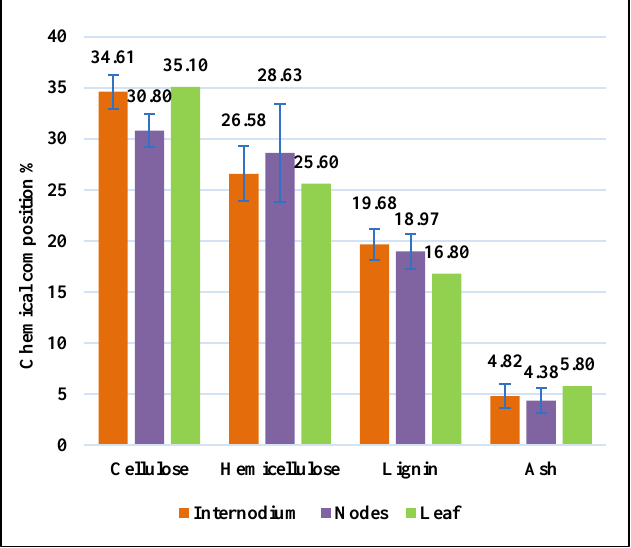
Figure 3: Biomass yield of giant reed plantations in the Mediterranean environment Source: Christou et al. (2003); Angelini et al. (2005; 2009); Cosentino et al. (2006; 2008); Mantineo et al. (2009); Ceotto & Di Candilo (2010); Roncucci et al. (2012); Nassi o Di Nasso et al. (2011a, b, 2013a, b); Ceotto et al. (2015); Dragoni et al. (2015, 2016